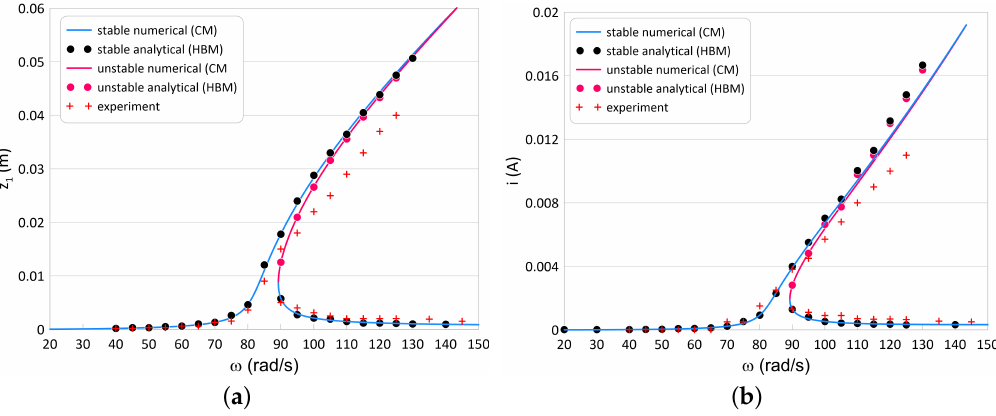
Figure 13. Magnet’s resonance curve ( a ) and the recovered current ( b ) for R = 10 k Ω and α = 25 Vs/m. The marked black points denote the HBM results, the blue and red lines mean numerical results and the plus signs are experimental results. The foldover effect toward high frequencies is observed. This is commonly named hardening.